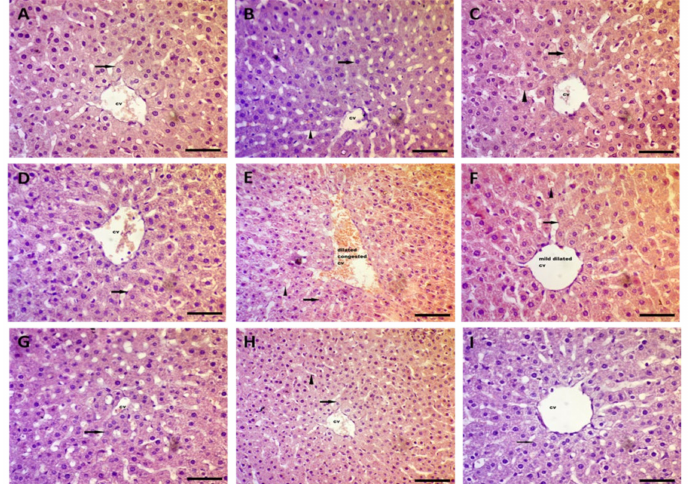
Figure 6. Photomicrographs of rats’ livers (H & E × 200). ( A ) Normal control rat sections showed normal architecture with normal central veins cv in the center of hepatic lobule with hepatocytes peripherally arranged, as shown by arrows. ( B – D ) Normal rats injected with Kn at different doses (0.25, 0.5 and 1.0 mg/kg, respectively) displayed normal architecture with mild dilated central veins in the center of hepatic lobule with hepatocytes peripherally arranged, as shown by the arrows, and separated by sinusoids (arrow head). ( E ) Hepatic sections of CP (7.0 mg/kg)-treated group showed marked dilation and congestion of the central veins in the center of hepatic lobule with hepatocyte degeneration near central vein and were peripherally arranged with a vacuolated to clear cytoplasm, and separated by dilated and congested sinusoids (arrow head). ( F , G ) Combination of cisplatin with Kn (0.25 and 0.5 mg/kg) restored the normal architecture of hepatocytes with mild congestion in central veins in the center of hepatic lobule with hepatocytes peripherally arranged (arrow) and separated by sinusoids (arrow head). ( H ) The highest Kn dose (1.0 mg/kg) restored the normal architecture of hepatocytes. ( I ) Combination of cisplatin with 200 mg/kg vitamin C restored the normal architecture of hepatocytes with mild congestion in central veins in the center of hepatic lobule with hepatocytes peripherally arranged (arrow) and separated by sinusoids (arrow head), (H & E ×